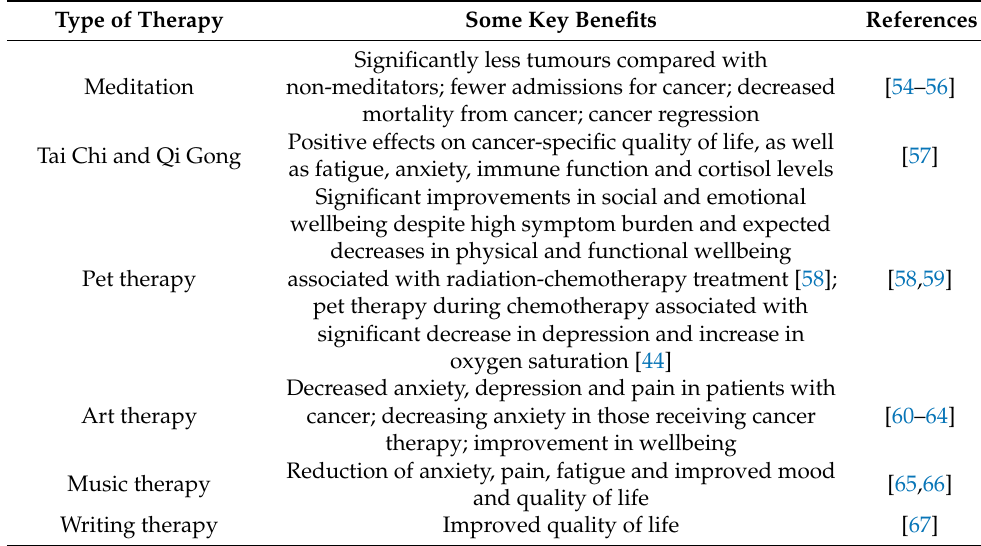
Table 1. Examples of stress reduction therapies useful for cancer patients. Type of Therapy Some Key